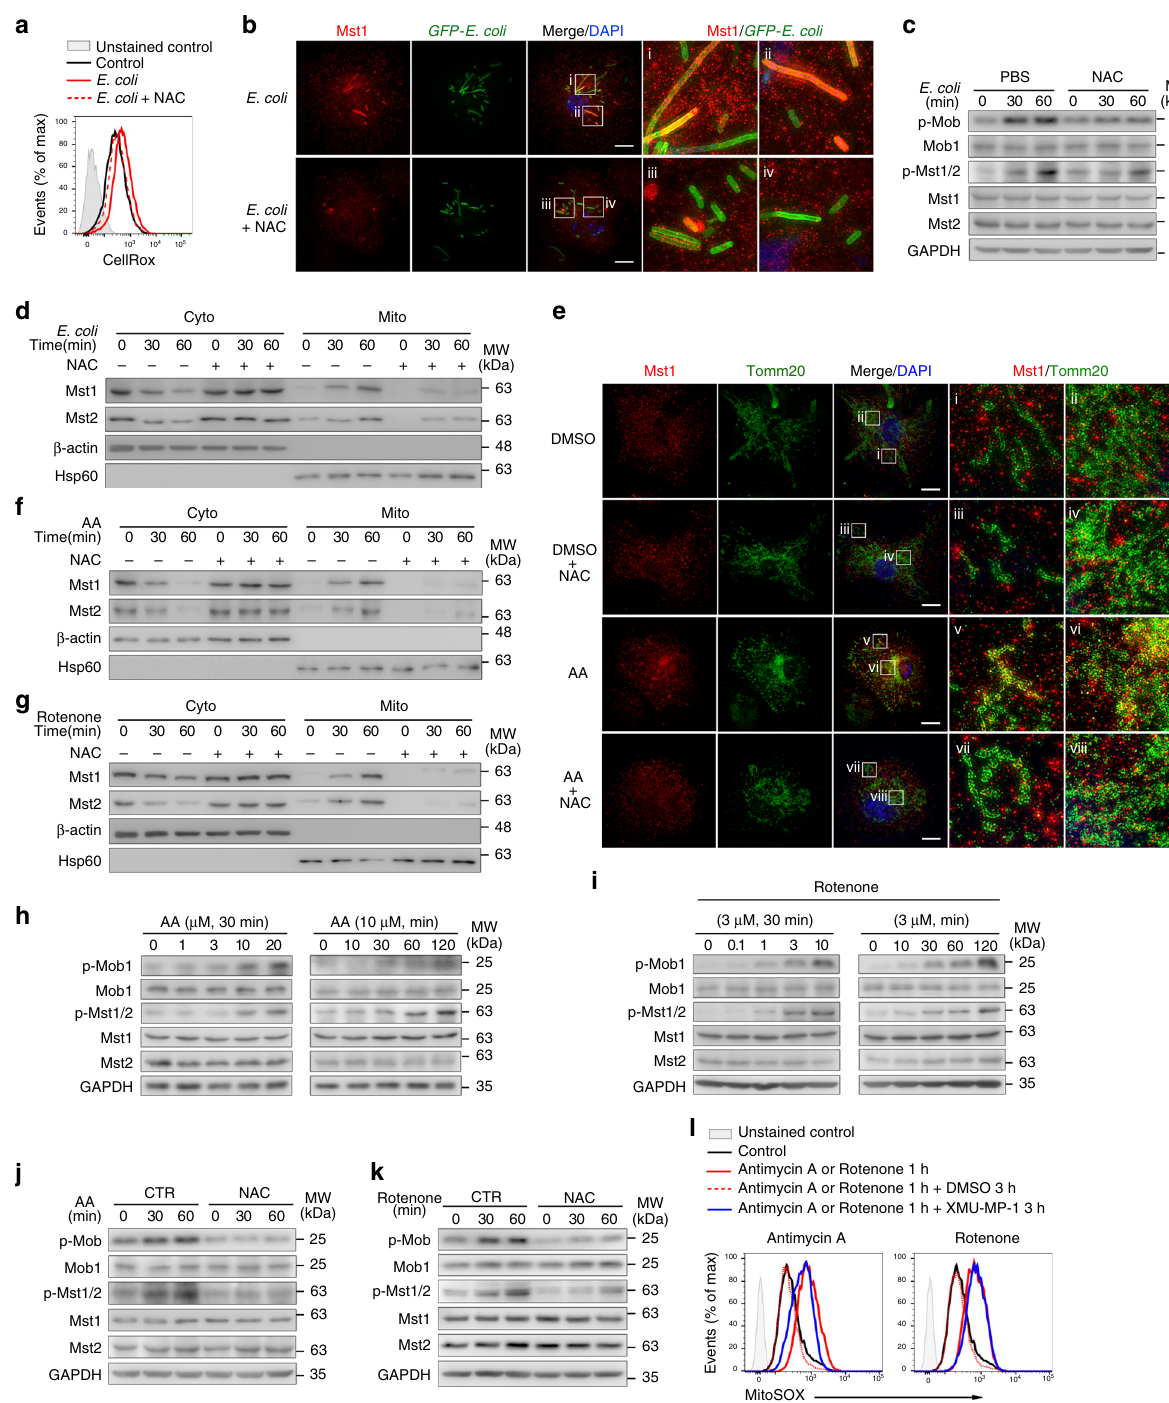
measured by immuno fl uorescence microscopy. DKO macro- phages had shorter telomeres (Fig. 2f) and fewer telomere foci (Fig. 2g, h) than WT cells at 8 and 12 months of age, although the differences in telomere length and number were not signi fi cant at 2 months of age, suggesting that loss of Mst1/2 promotes telomeric loss and causes premature ageing. In addition, we found that the number of telomere foci in peritoneal macrophages of DKO mice received NAC supplementation in drinking water for 7 months from 1-month old, was signi fi cantly increased (Fig. 2i). Taken together, these data indicate that Mst1/2 might play an essential antiageing role in macrophages.